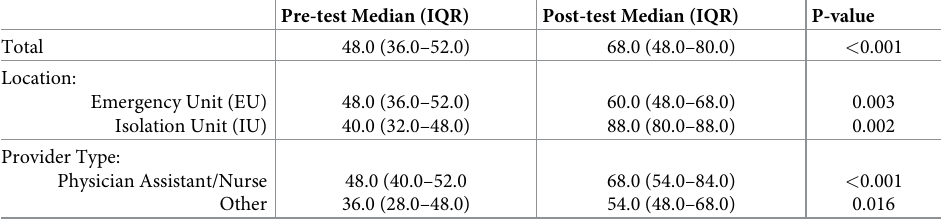
Table 2. Pre- and post-test course scores total, by location and provider type.